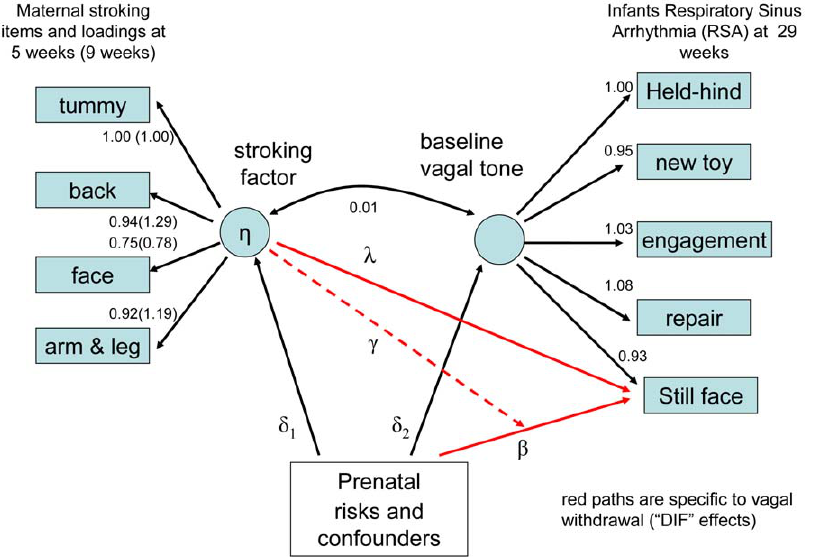
Figure 2. Latent variable model for stroking items and respiratory sinus arrhythmia (RSA) estimate of vagal tone. The figure shows the factor loadings for mothers’ reports of stroking at 5 and 9 weeks, and RSA at 29 weeks. The values of l (direct effect of stroking on vagal withdrawal), d 1 , d 2 , and b (associations of risks and confounders with stroking, vagal tone and vagal withdrawal respectively), and c (interaction between maternal stroking and prenatal maternal depression), are shown in Table